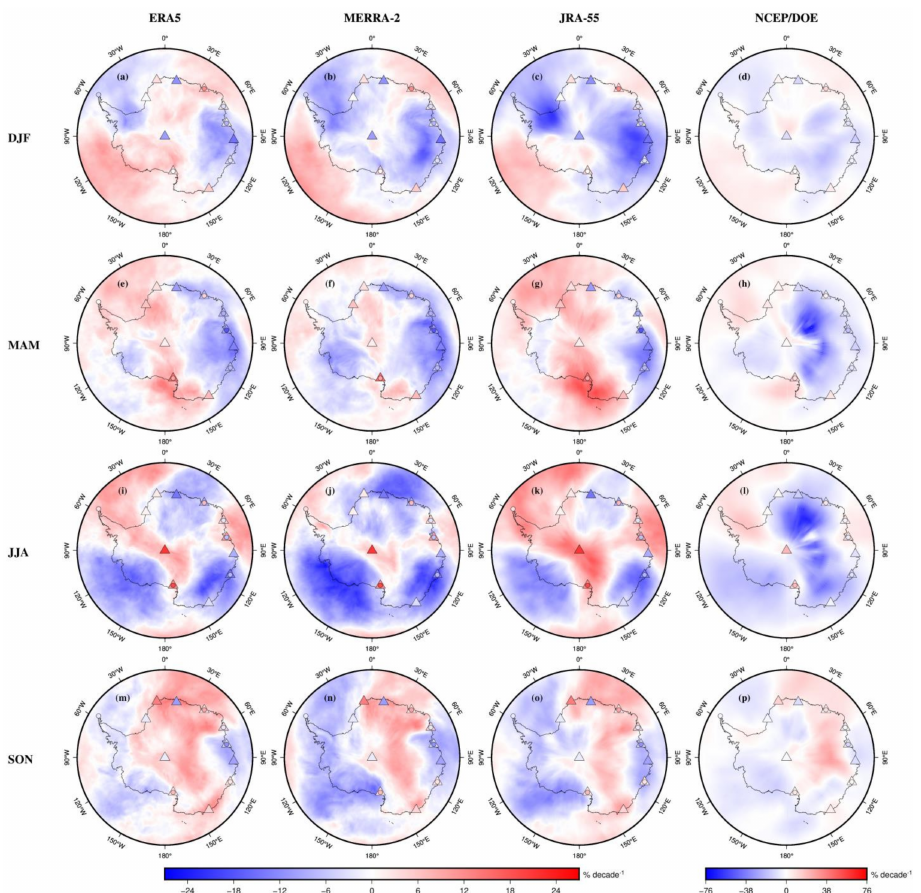
Figure 15. Seasonal relative PWV trends over Antarctica derived from ( a , e , i , m ) ERA5, ( b , f , j , n ) MERRA-2, ( c , g , k , o ) JRA-55, ( d , h , l , p ) NCEP/DOE reanalysis (color shading), GNSS (color circles) and radiosonde (color triangles) for the four seasons from 2001 to